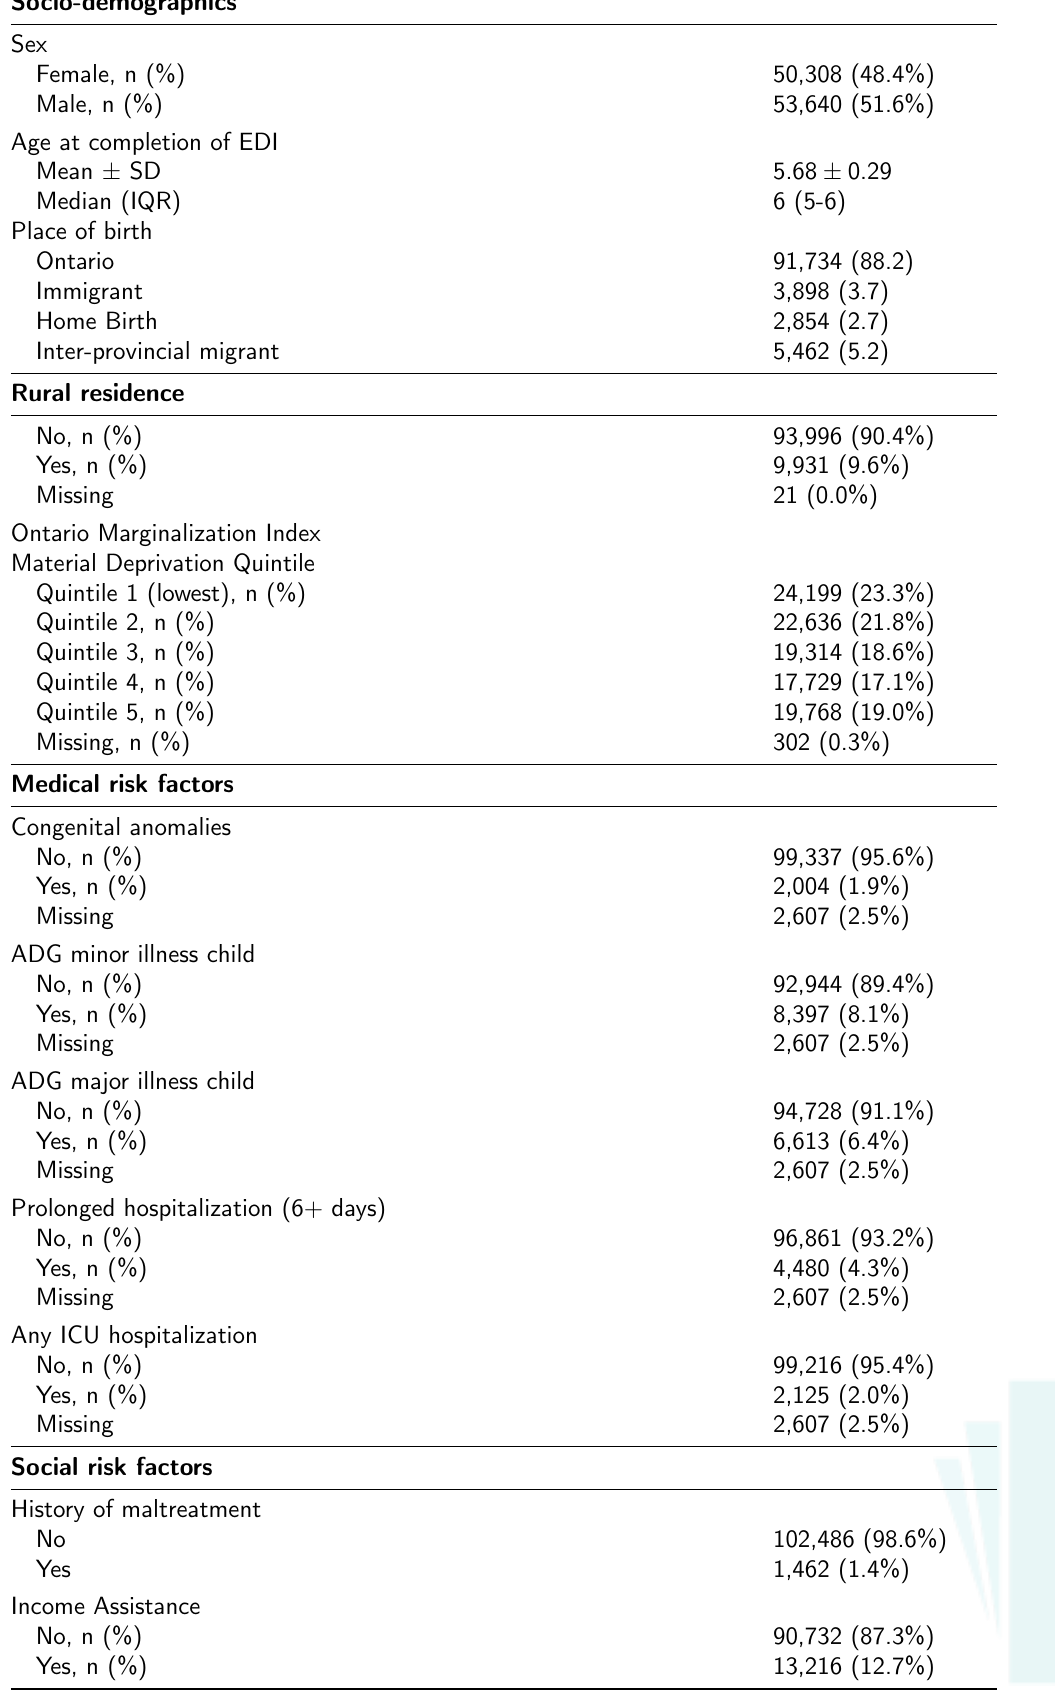
Table 2: Characteristics of the study cohort used to assess social and medical risk factors for vulnerability